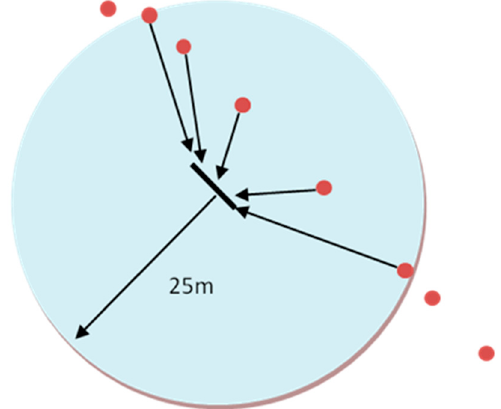
Figure 1. Process of assigning data points to line segments. Each spatially identified pollution concentration reading (red circle) within the search radius of 25 m (blue circle) is assigned to the nearest 1 m segment (black line) and the mean value was taken. Predictor variables are also assigned to each 1 m in similar fashion for statistical